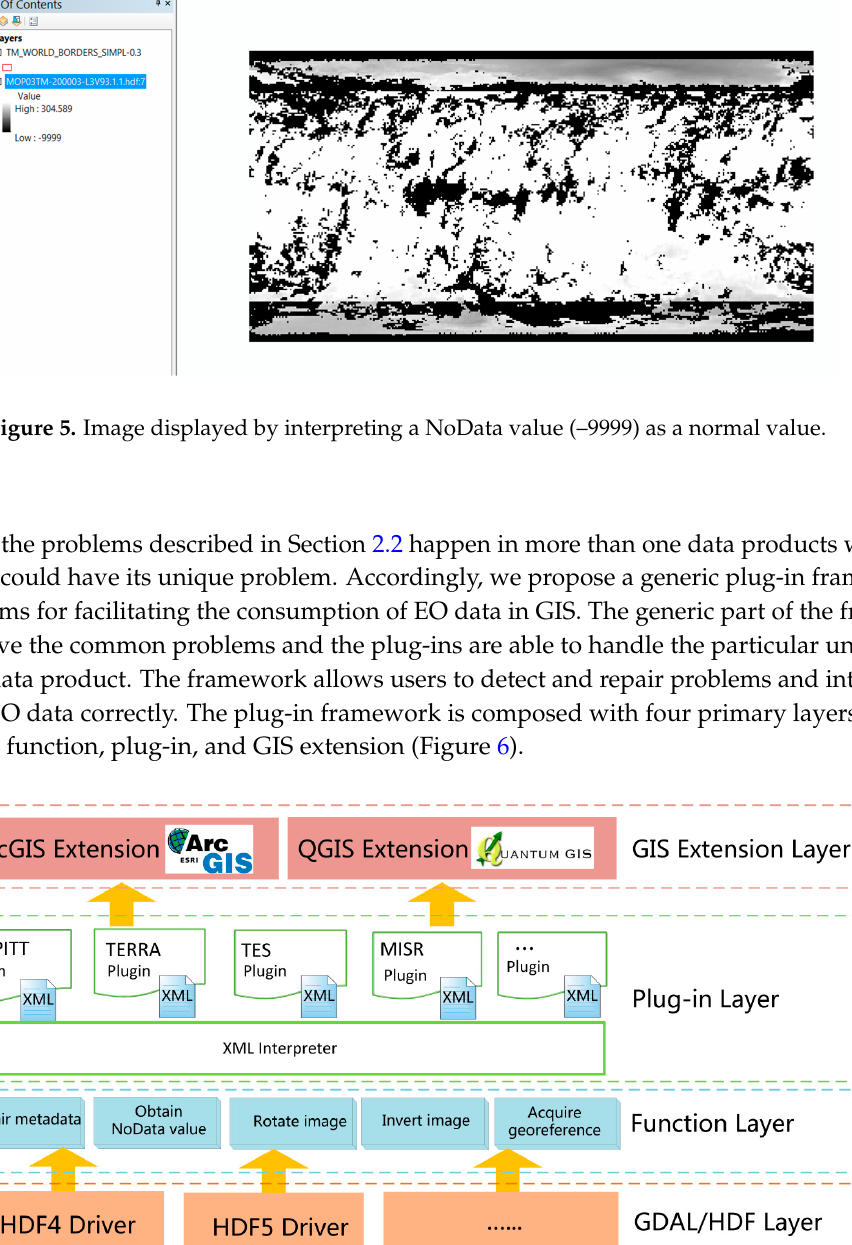
Figure 6. A generic XML-based plugin framework.